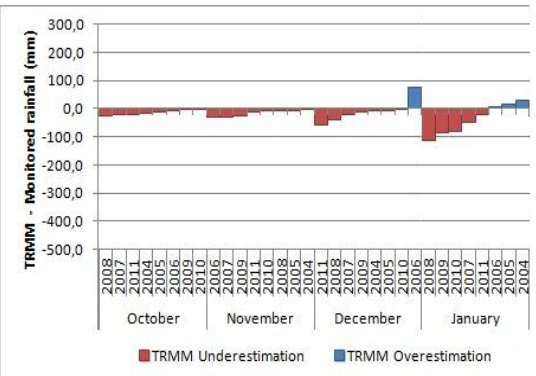
Figure 16. Overestimation and underestimation from